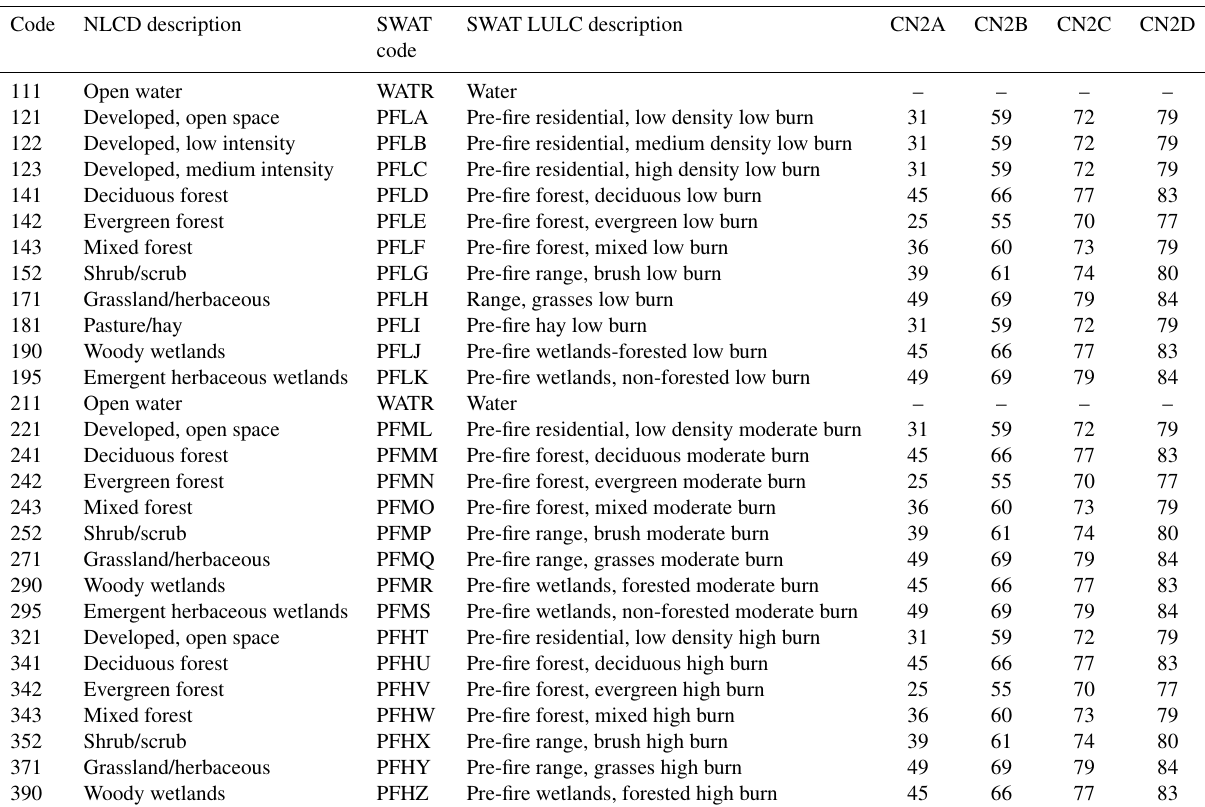
Table A4. Pre-wildfire edited lookup table and corresponding curve